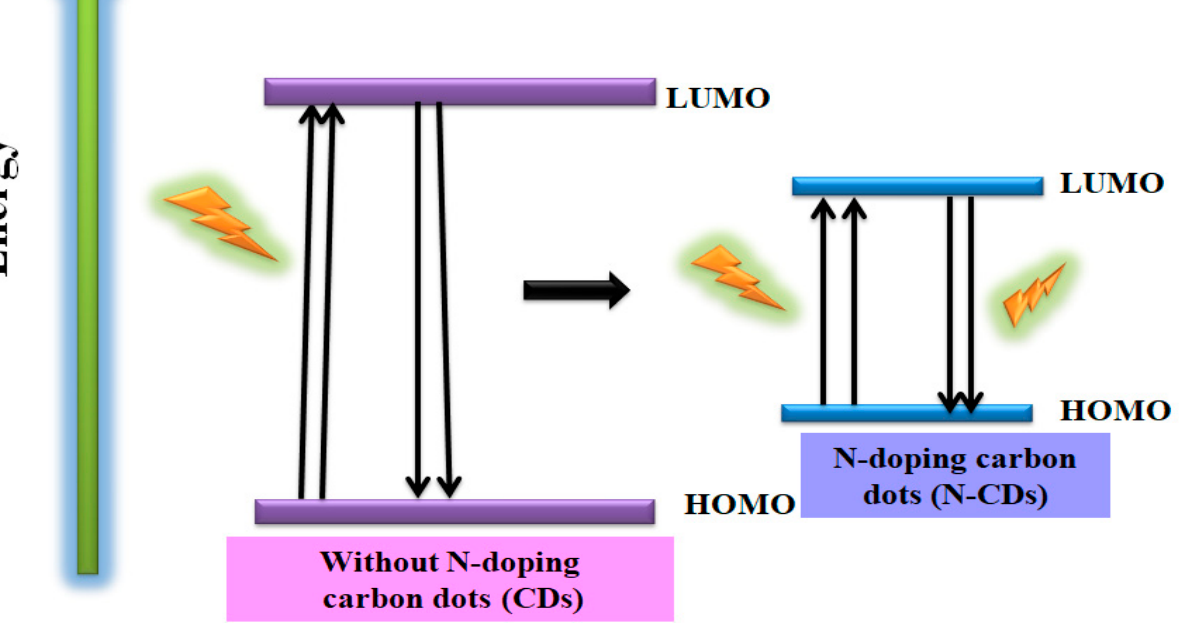
Figure 9. Energy diagram of CDs without doping and with N-doping.